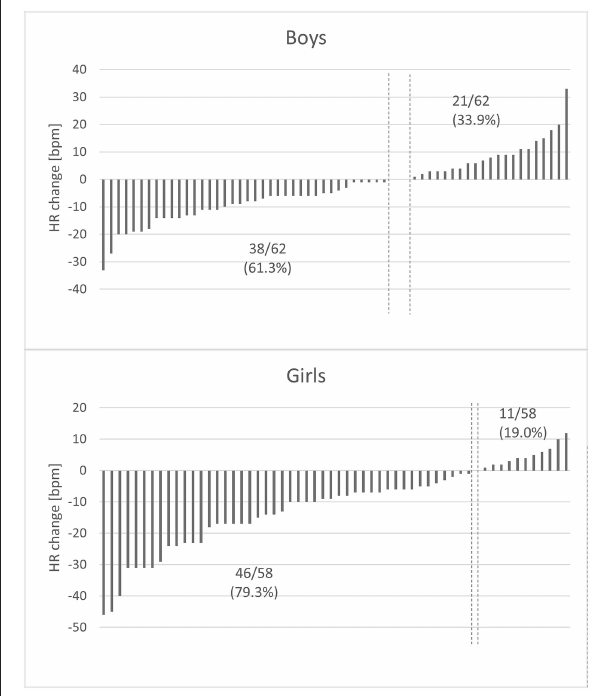
FIGURE 5 | Changes in heart rate in relation to sex. The y-axis represents heart rate difference (the 2019 HR value – the 2016 HR value), with each column representing one child. The x-axis represents study participants arranged by HR difference. The vertical dashed lines symbolize class limits between participants whose HR increased and decreased over the course of our study. HR decreased in 79.3% of girls and only in 61.3% of boys. There was a substantial difference between the degree of HR change observed in boys and in girls ( p =